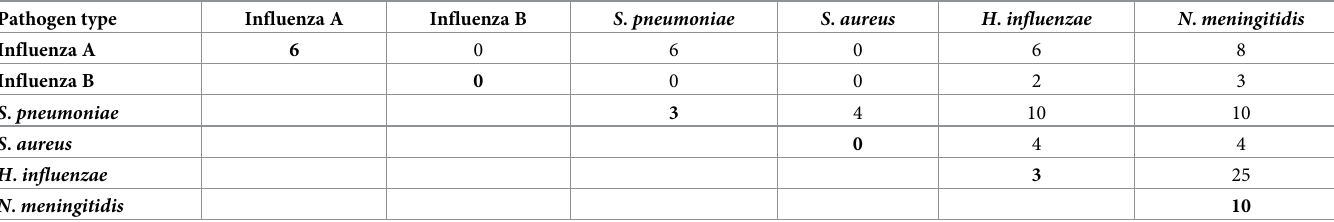
Table 3. Influenza and bacterial